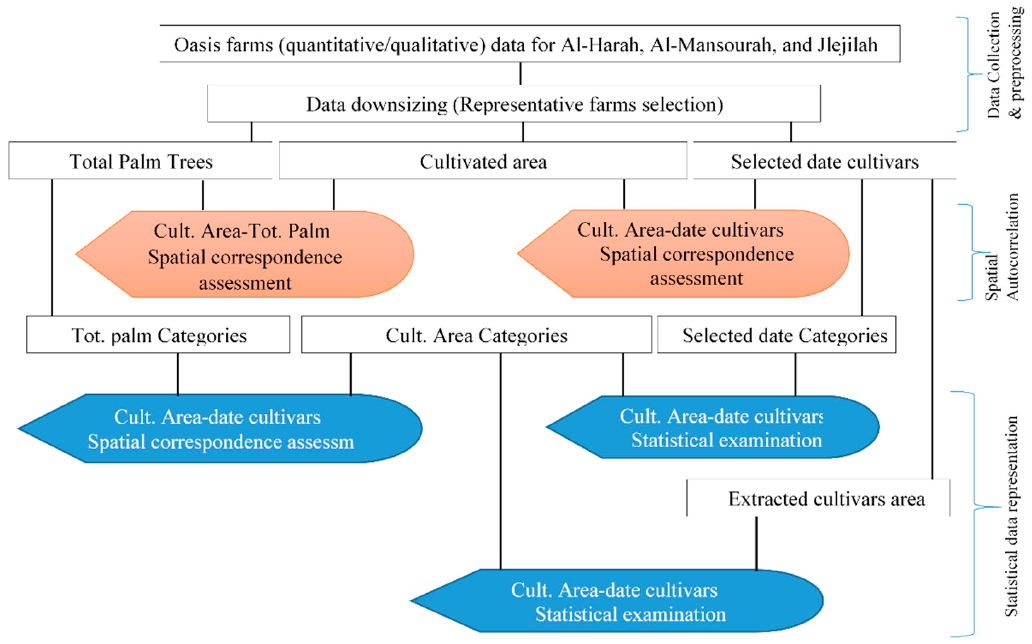
Figure 2. Flow chart of the applied spatial and statistical correlations.